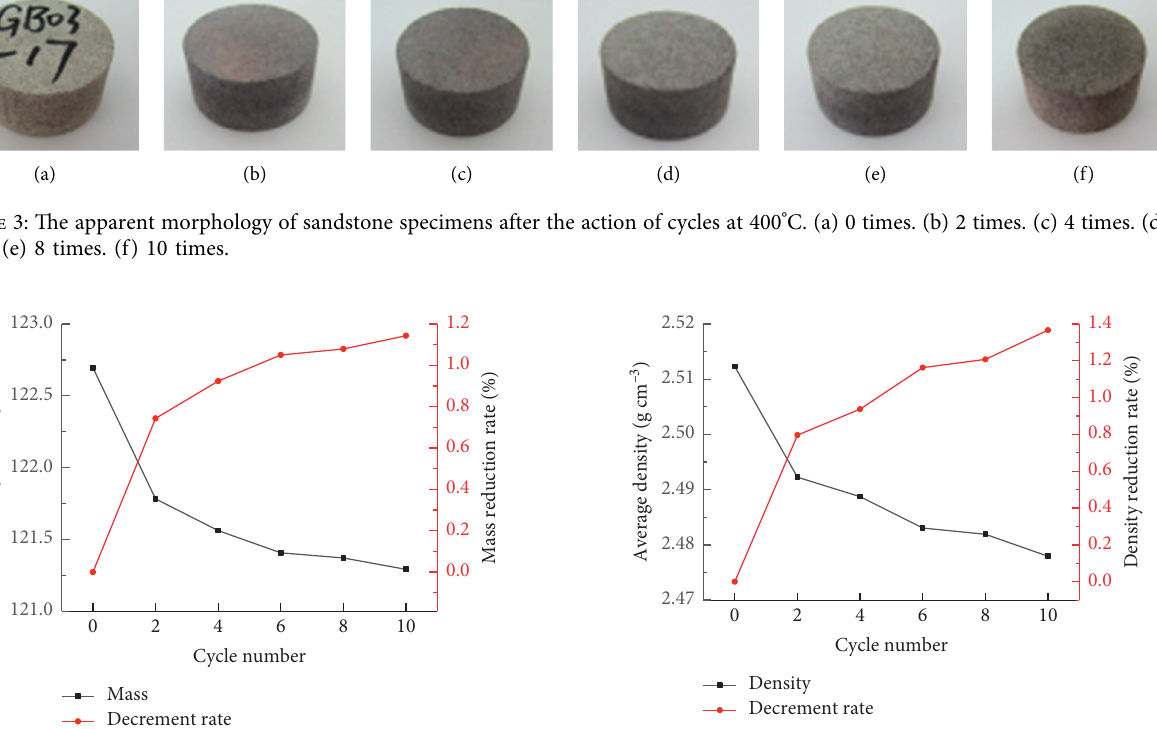
Figure 4: The relationship between the mass of specimen and the number of cycles at high temperature.